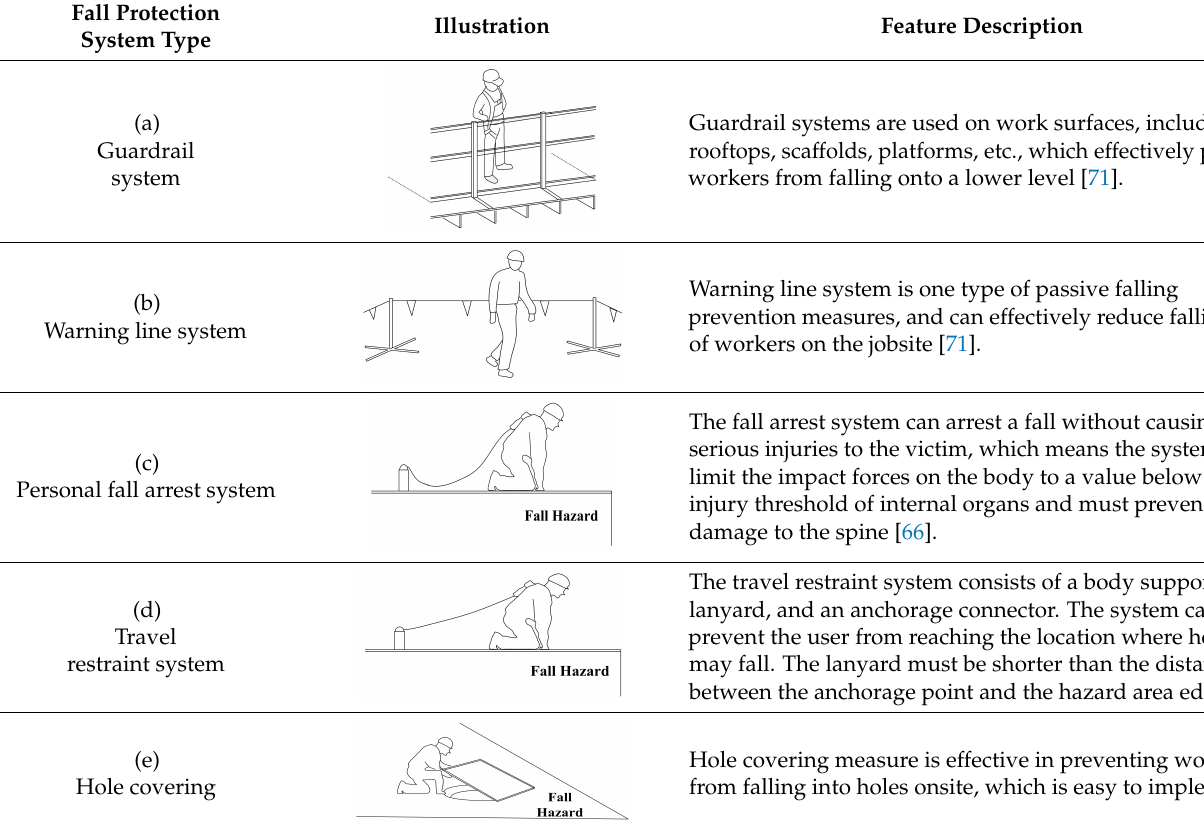
Table 3. Illustration of feasible fall protection systems.